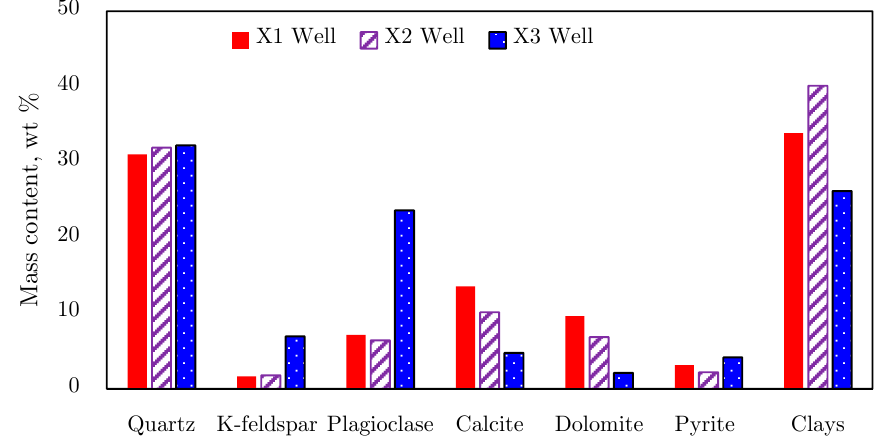
Figure 3. Relative content of minerals of samples from the Longmaxi Formation in the south Sichuan Basin.